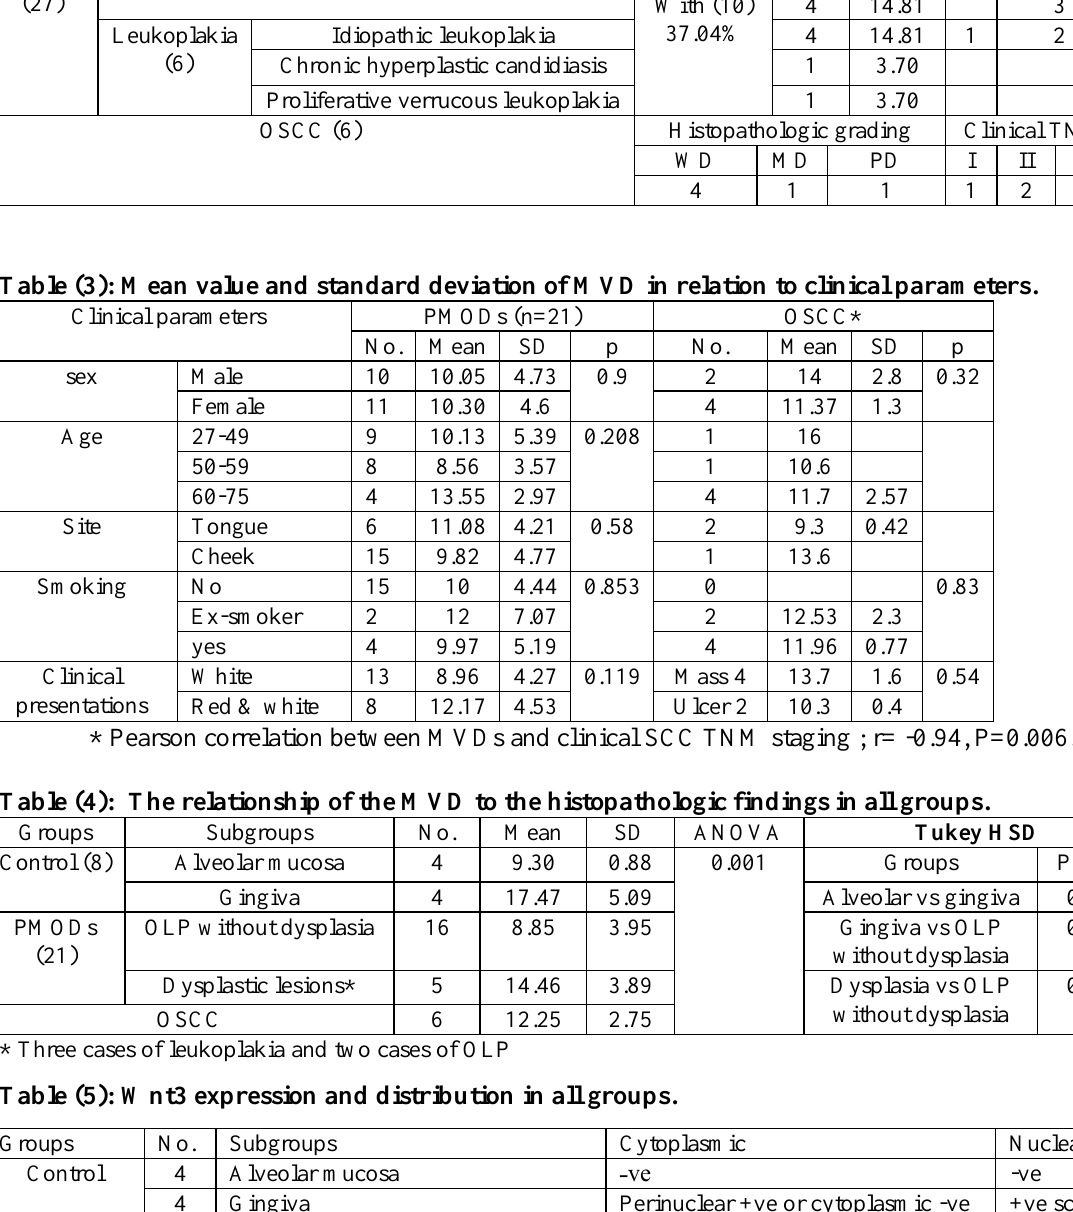
Table (2): histopathological characteristics of PMODs and TNM staging of OSCC Groups Dysplasia No. % Grading for dysplasia PMODs